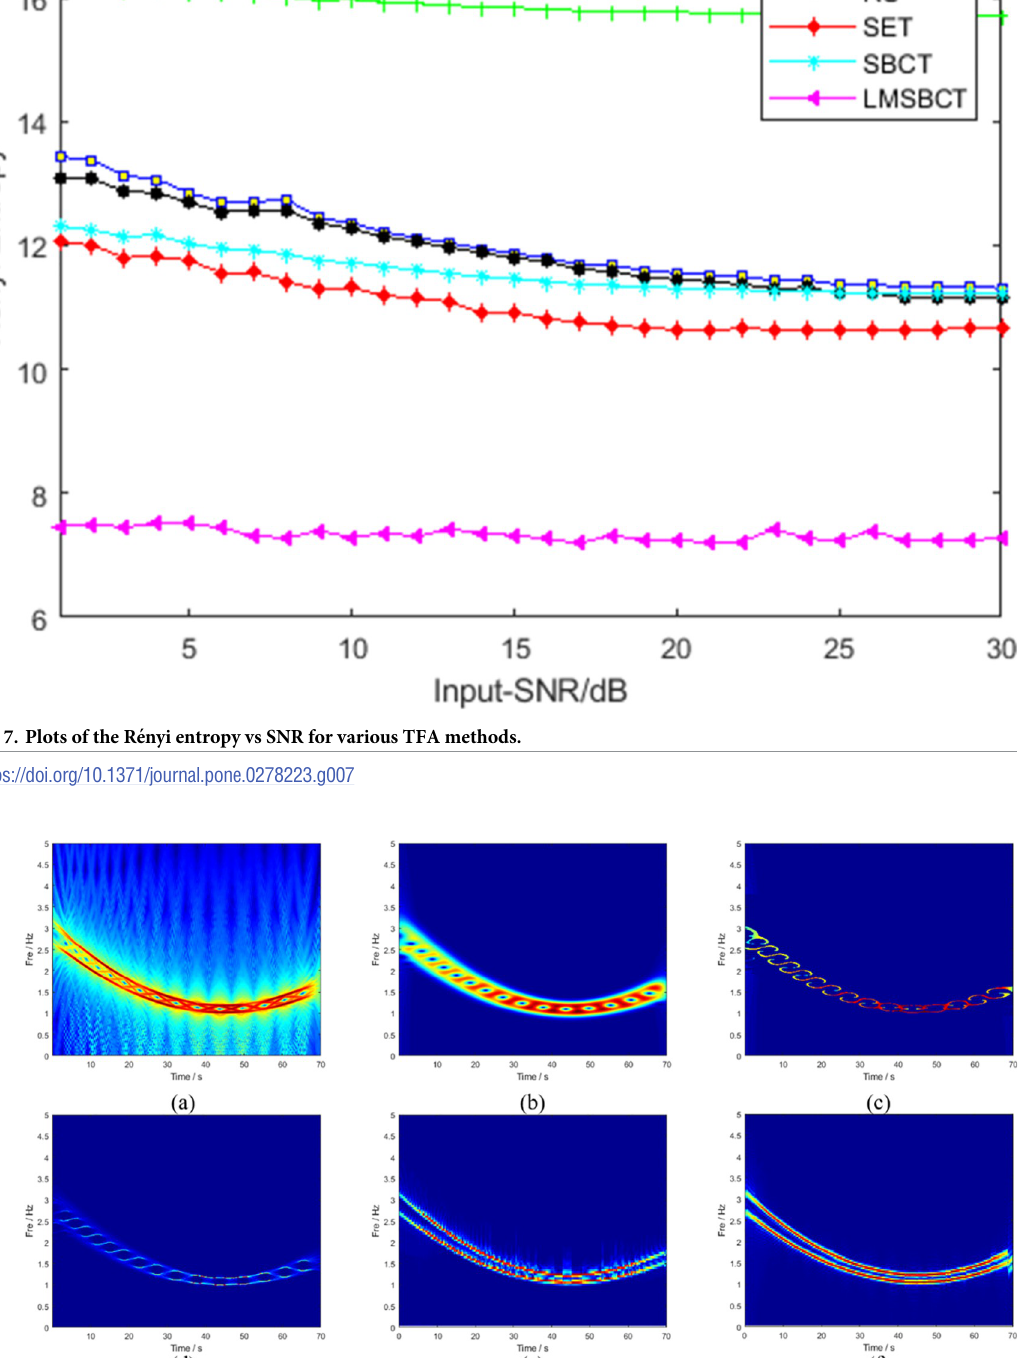
PLOS ONE | https://doi.org/10.1371/journal.pone.0278223 November29,